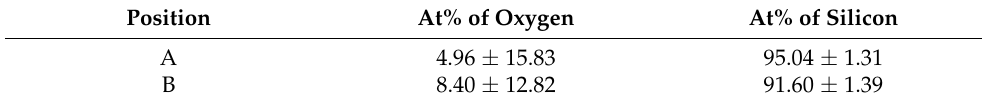
Figure 2. ( a ) Typical surface image of the layer and ( b ) at a higher magnification (A: normal area; B: submicronic ball-like particles). Table 2. Oxygen content determined using EDS for the two positions (A and B) indicated in Figure 2.